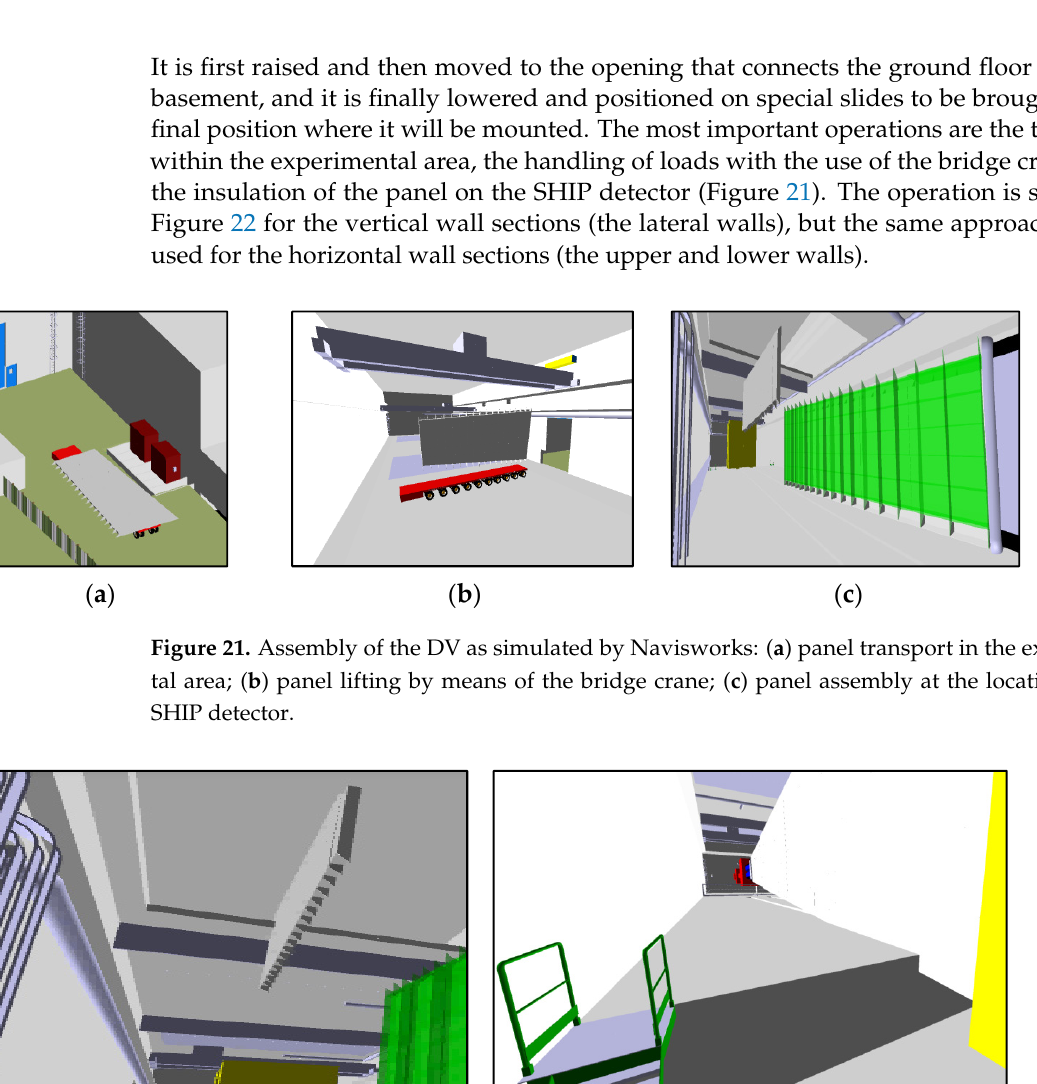
Figure 23. Image of the experimental area with Autodesk Navisworks. After the model import phase, the following step regards the Timeliner tool settings using the Work Breakdown Structure (WBS) created with Microsoft Project. It reports all the main processing phases associated with a certain time for the realisation. It starts from the construction of the on-site infrastructure up to the assembly of the DV at the final location of the SHIP detector. A work-breakdown structure (WBS) in project management and systems engineering is a deliverable-oriented breakdown of a project into smaller components. A work breakdown structure is a key project deliverable that organises the team’s work into manageable sections. Each work is assigned to a BIM element in Navisworks corresponding to a specific phase in the time of the realisation of the entire system. 5.4. Interferences between Construction Tasks The verification of the interferences between the various models has been done through Navisworks using the Clash detection function. It allows for the setting of a series